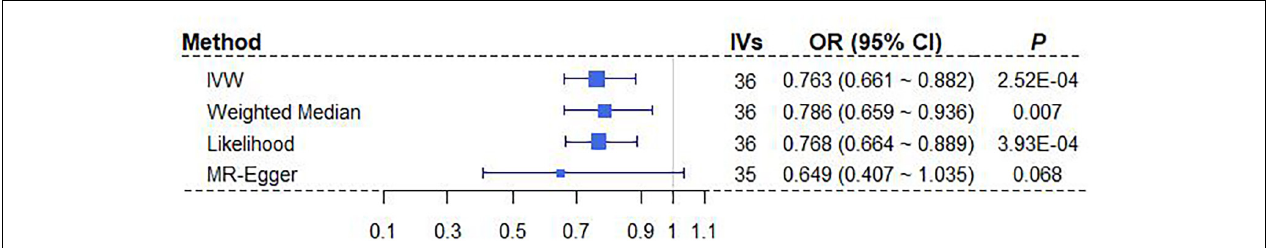
FIGURE 3 | Estimated causal effects of BMI on breast cancer with different MR approaches. MR-Egger regression was performed after removing the instrument of rs17024393. BMI, body mass index; IV, instrumental variable; IVW, inverse-variance weighted; OR, odds ratio; MR, Mendelian randomization.